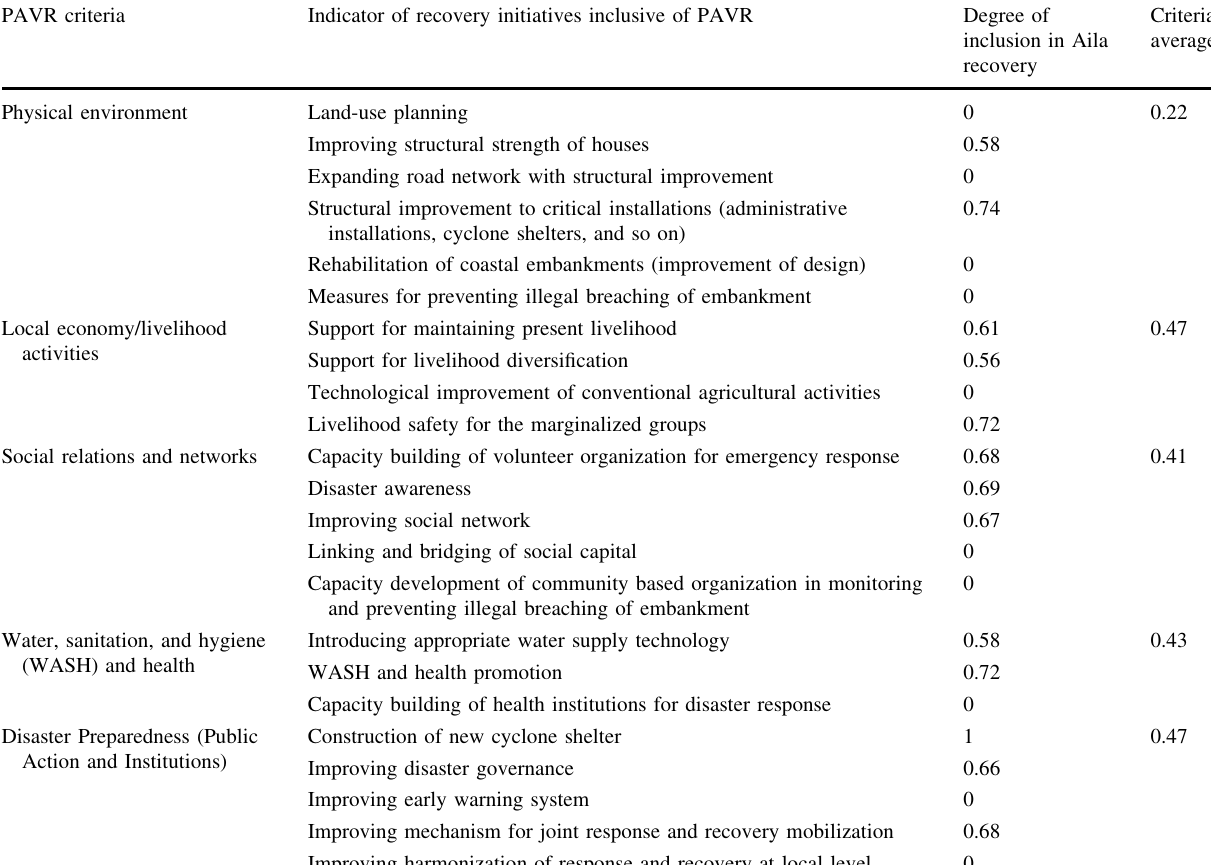
Table 3 Inclusion of PAVR measures in Aila recovery activities in Koyra Upazila, Khulna District, Bangladesh PAVR